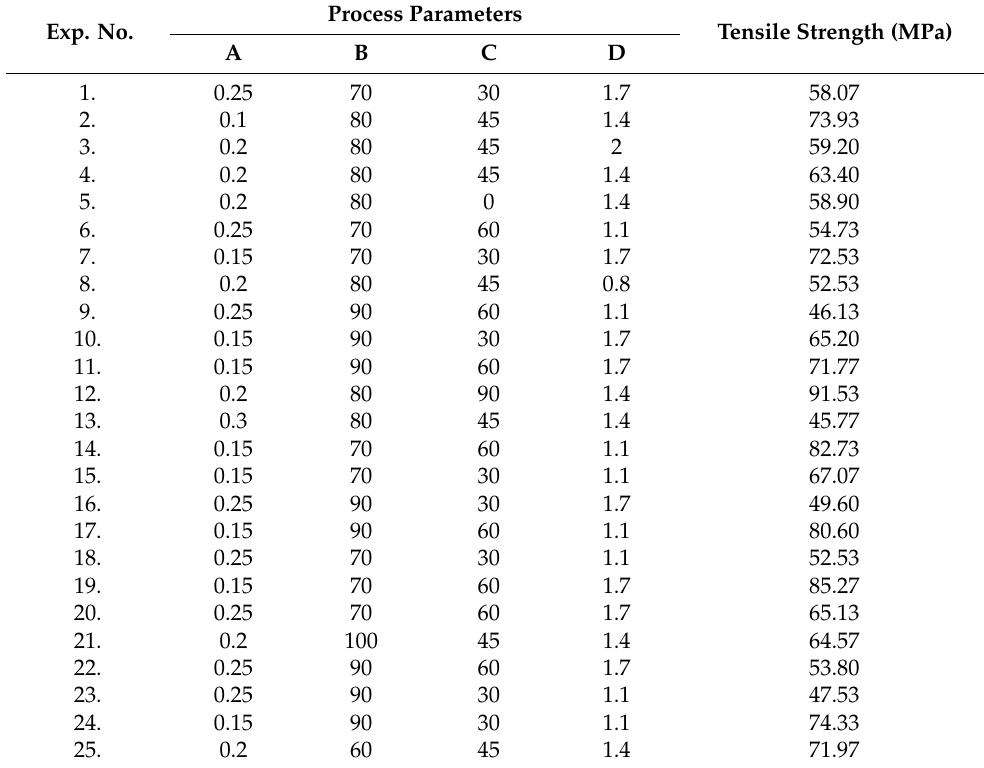
Table 5. ANN’s database.